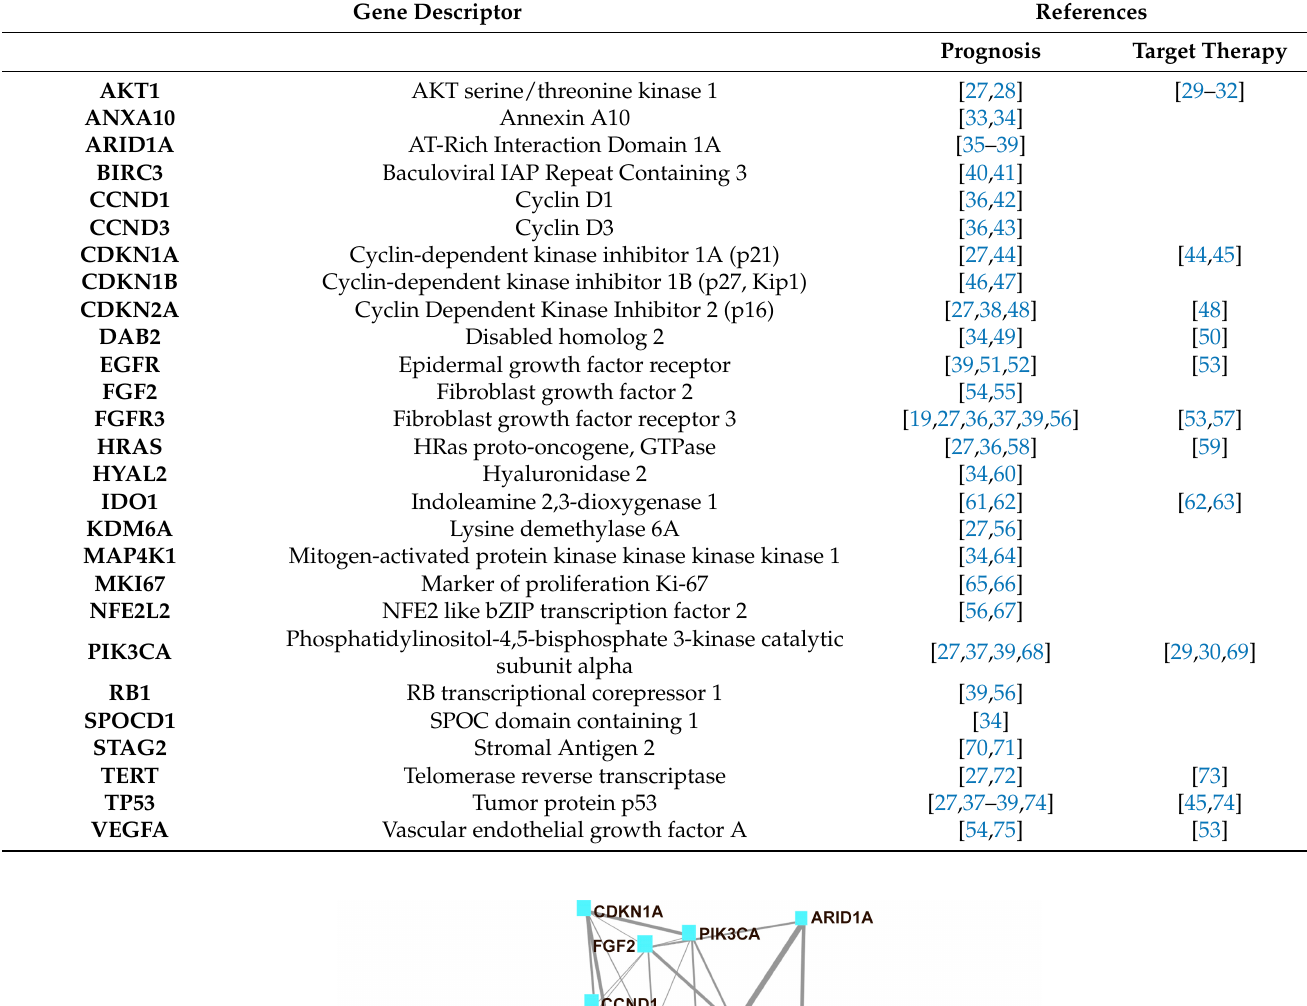
Table 2. Characteristics of the 27 bladder cancer-related genes in the study.